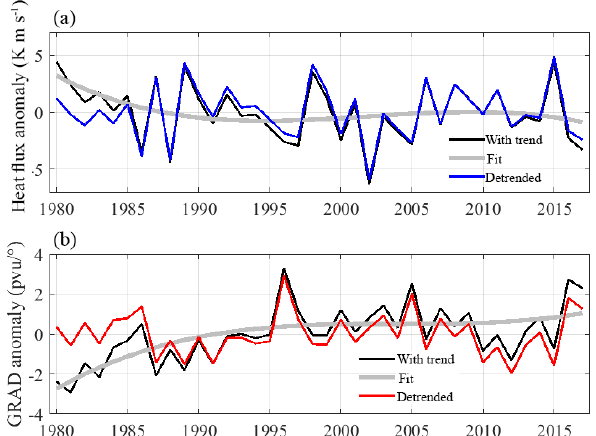
Figure 6. Heat flux (a) and gradient (GRAD) (b) anomalies for the 15 September–15 October period: before removing a polynomial fit of third order (black line), the fit (grey line) and after removing the fit (blue/red